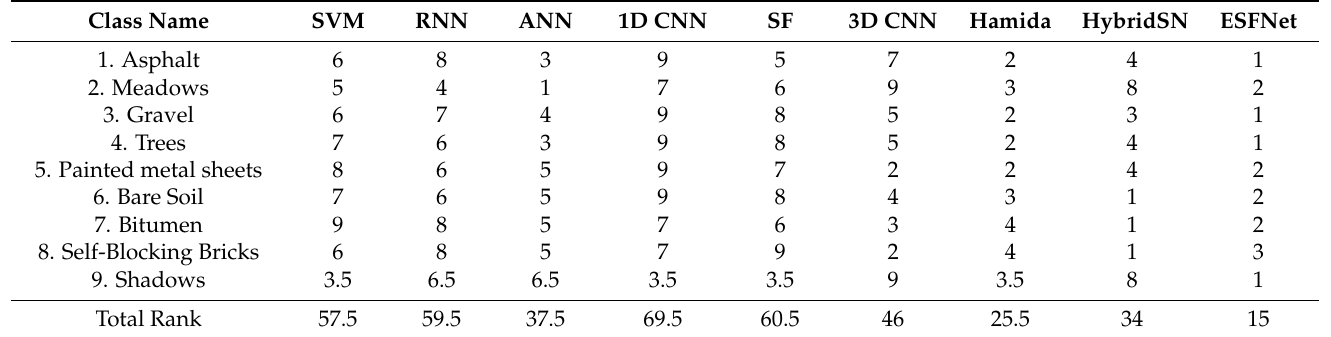
Table 8. Ranking of nine models on the categories of Pavia University